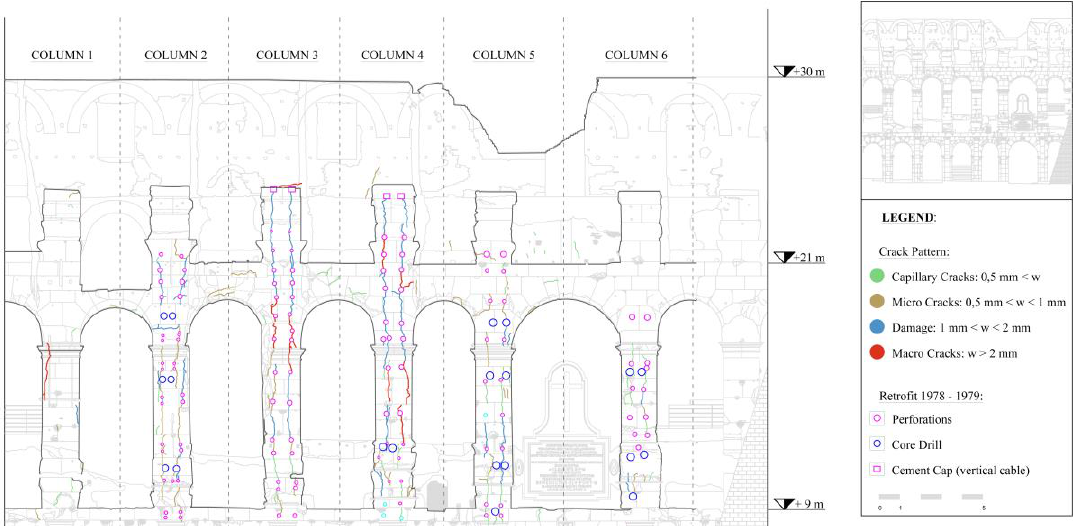
Figure 17. Crack pattern of the travertine columns at the second floor from the external point of